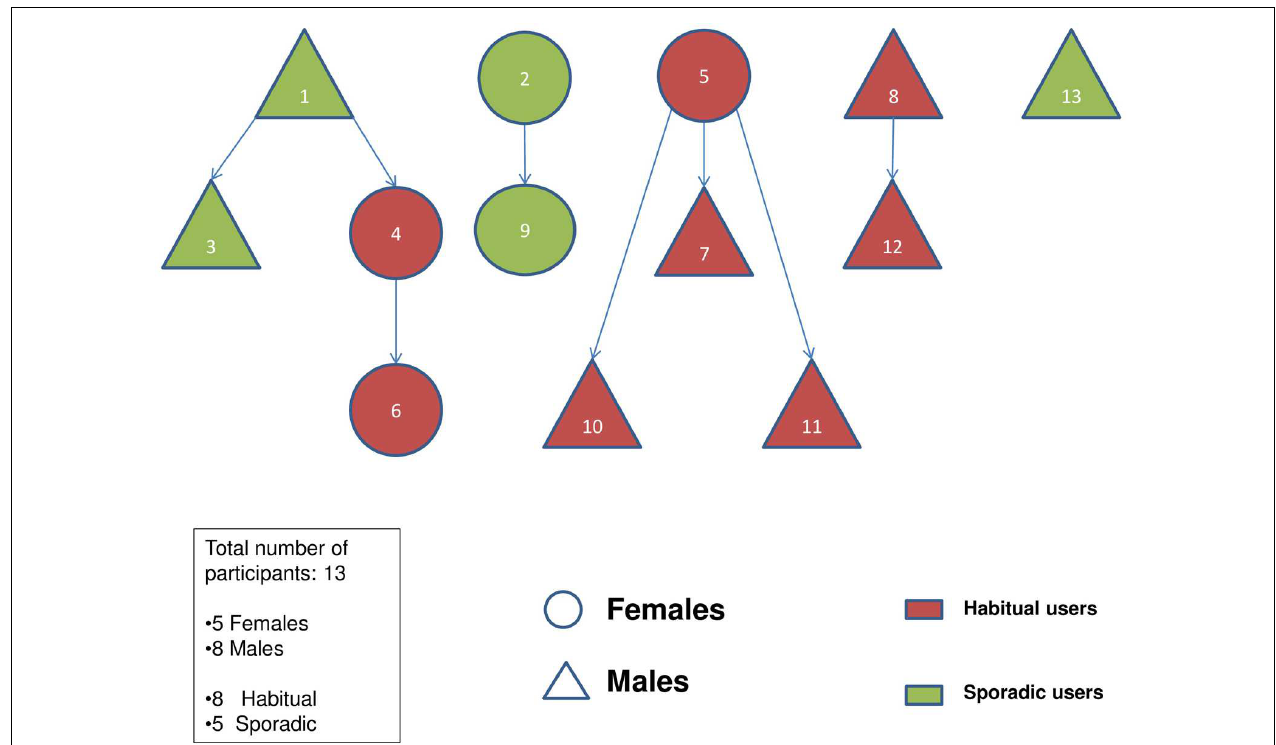
FIGURE 1 | Sociogram of the study population. Numbers represent the order of recruitment.